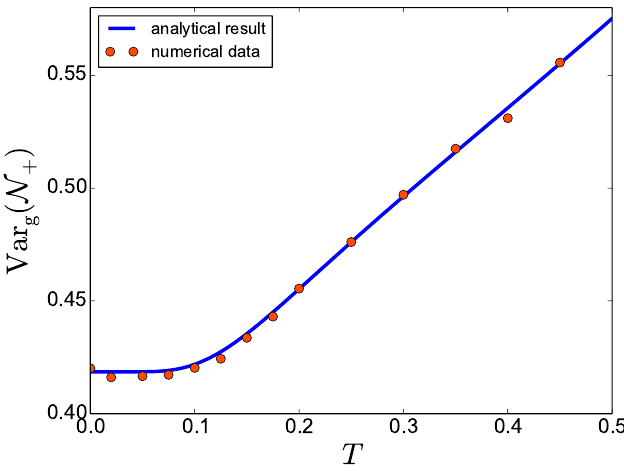
g = 100 as = 1). The points are obtained by averaging B